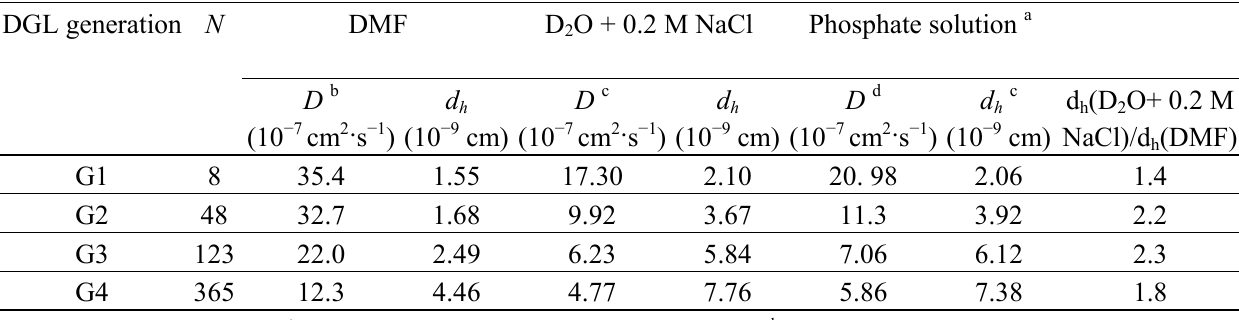
Table 1. Number-average polymerization degree N , average diffusion coefficient D and of DGL in different hydrodynamic diameter d h